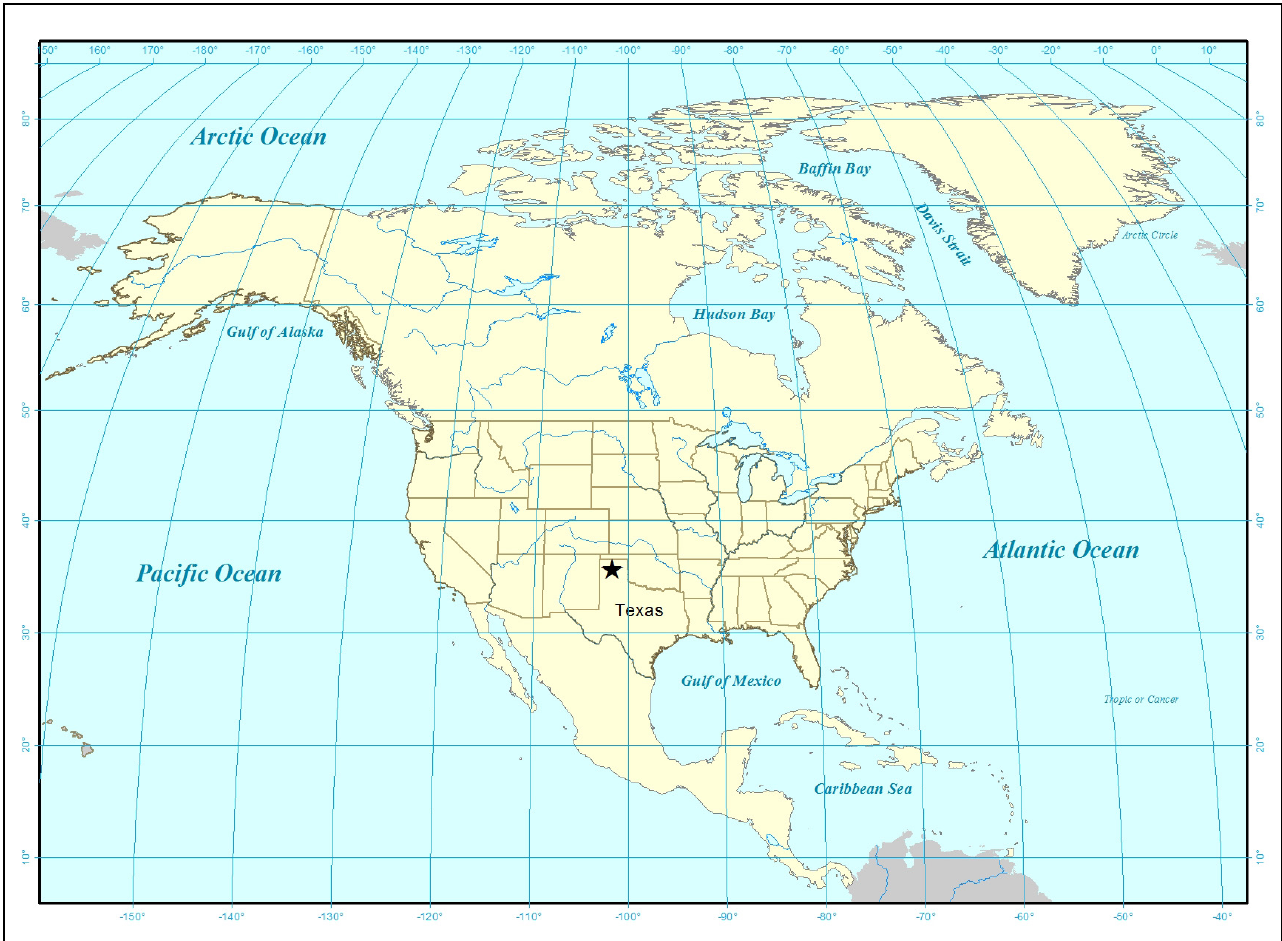
Figure 1. Geographic location of the Lake Meredith National Recreation Area (star) in the State of Texas, United States of America, North America (ESRI base